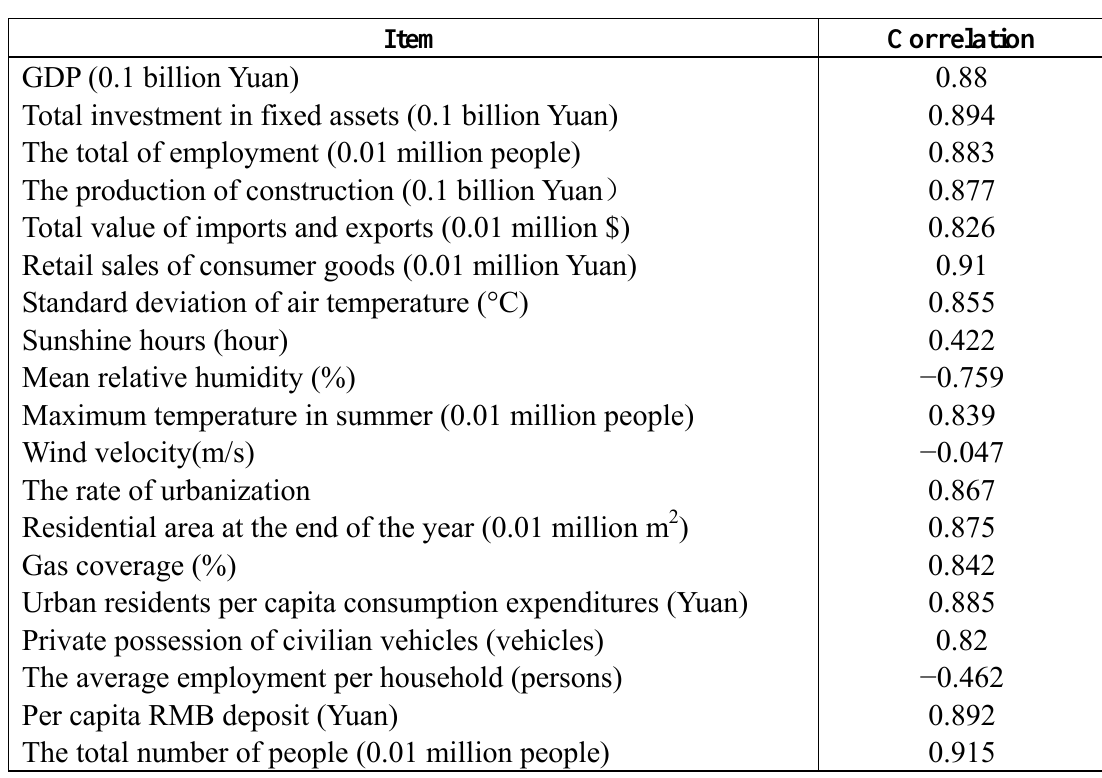
Table 2. Correlation coefficients.